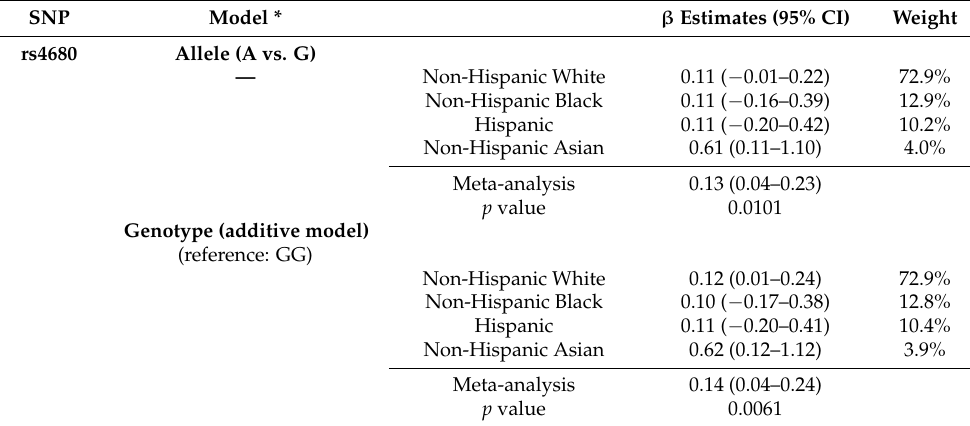
Table 3. Associations between hearing loss and allele and genotype of rs4680.